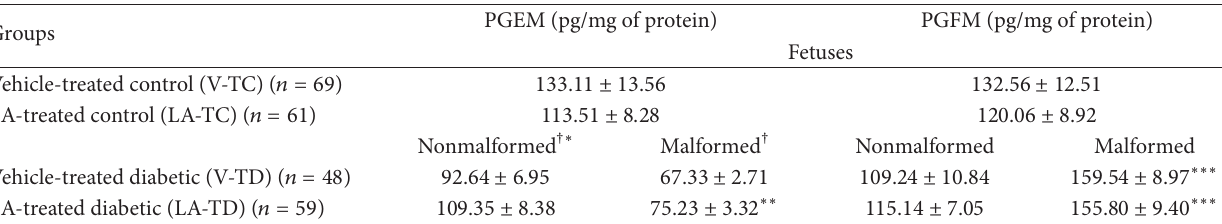
Table 8: PGEM and PGFM in fetuses.